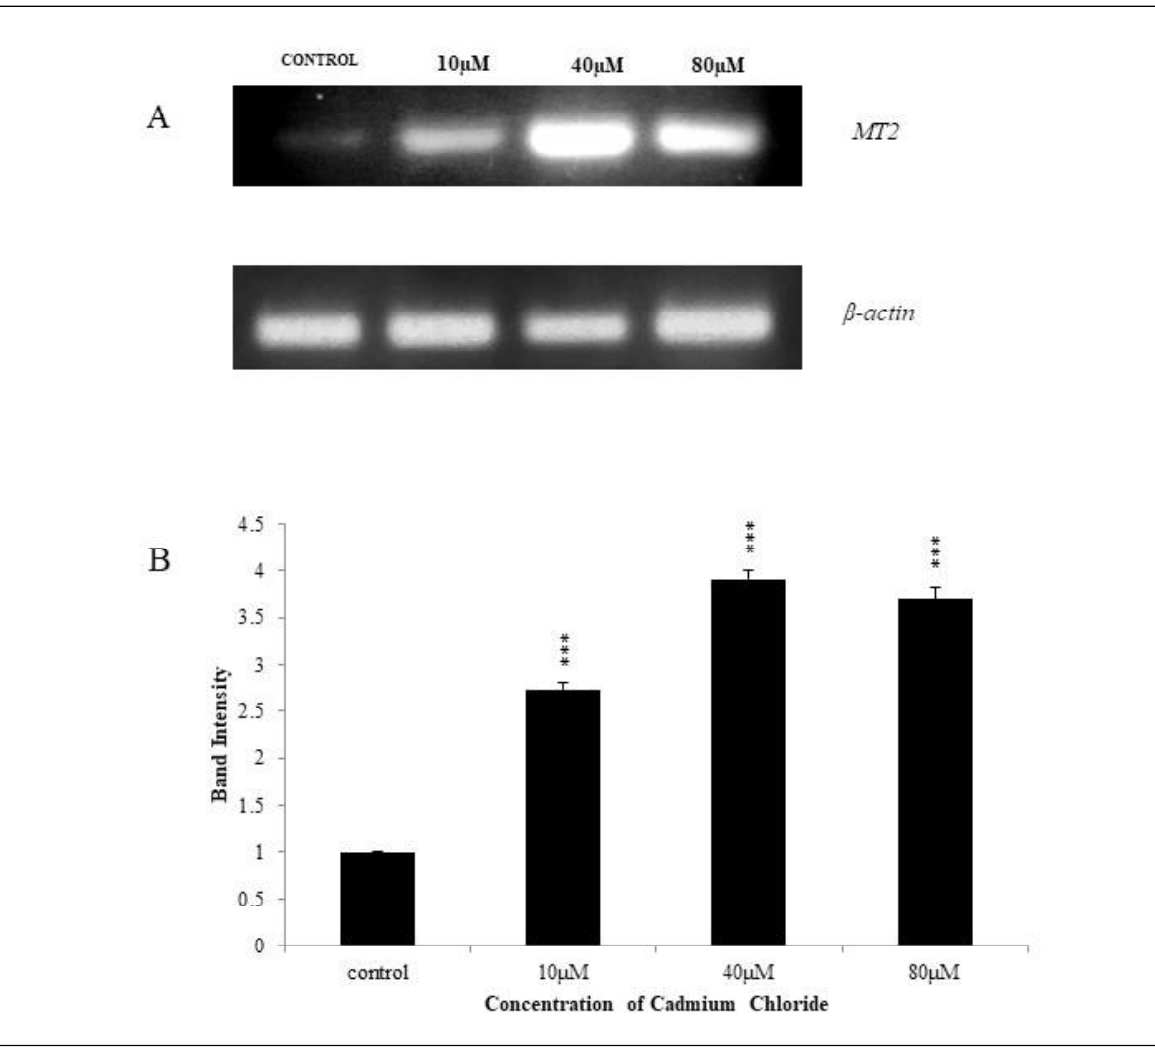
Figure 4: (A) Comparison of band intensities of expression levels of MT2 and  -actin , (B) Graphical representation of MT2 obtained via densitometric analysis of plants under no stress(control), 10  M, 40  M and 80  M CdCl stress respectively 2 Note: Asterisks denote the level of significance; * p  0.05, ** p  0.01 and *** p 